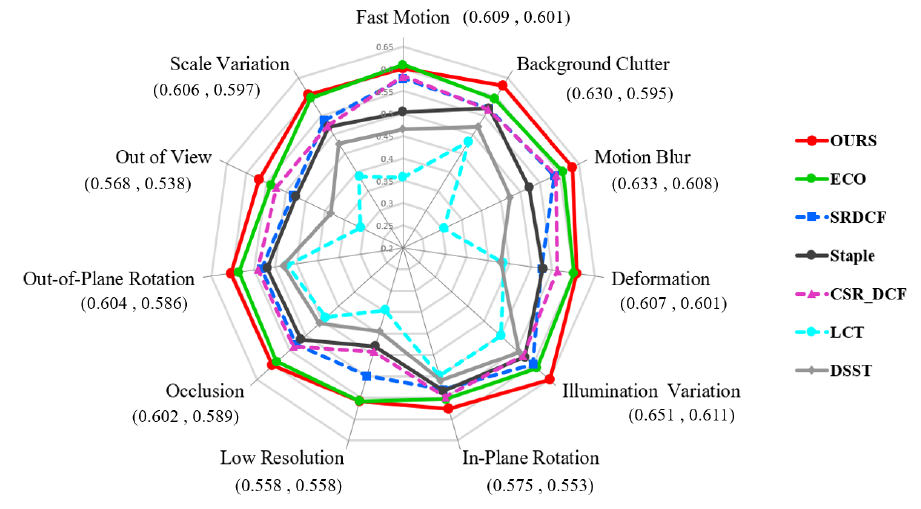
Figure 9. Comparison of area-under-curve (AUC) scores on all visual attributes on OTB2015.